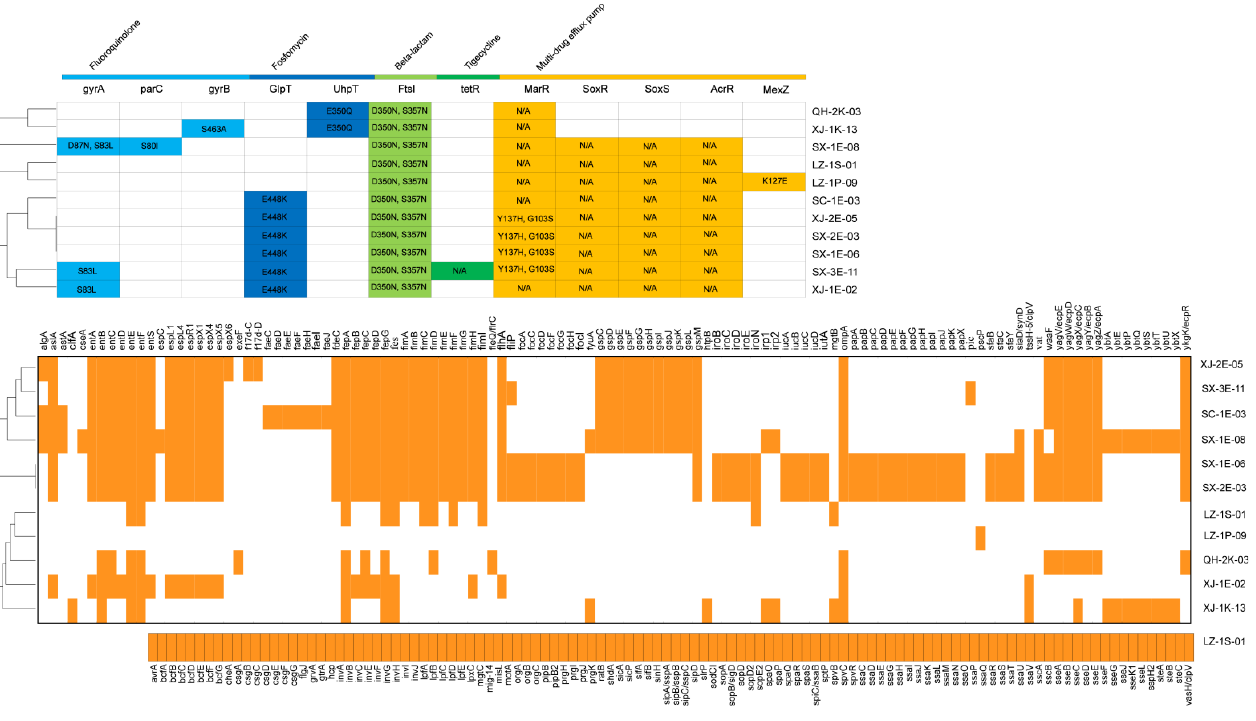
Table 4. ST and allele of tigecycline-resistant isolates.